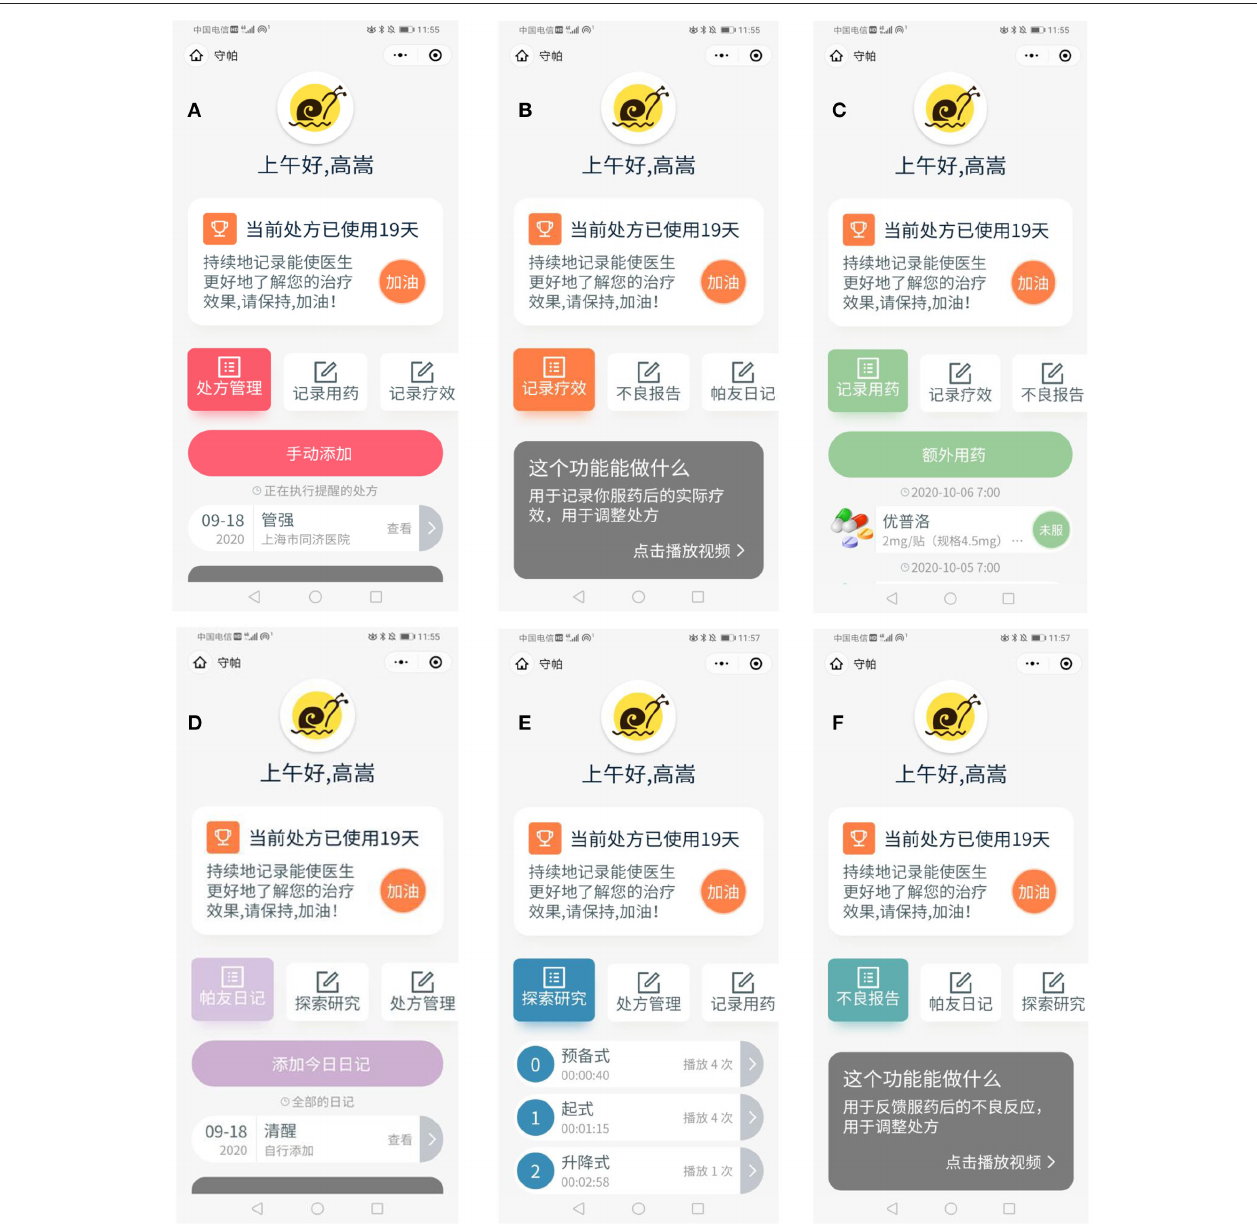
FIGURE 2 | “Shoupa” App intervention: (A) prescription management; (B) effect recording; (C) medication recording; (D) patient’s diary; (E) exploratory research; (F) adverse